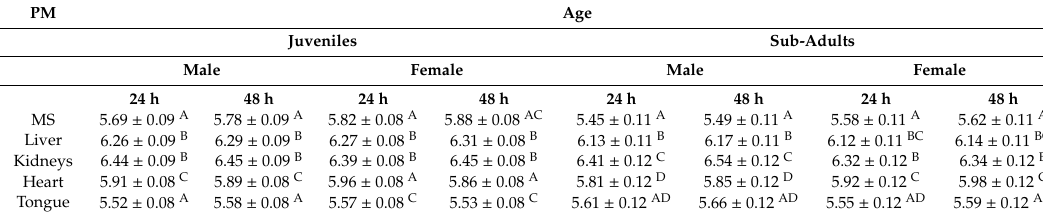
Table 2. The pH values of meat and edible o ff al from the wild boar (mean ± SD). PM